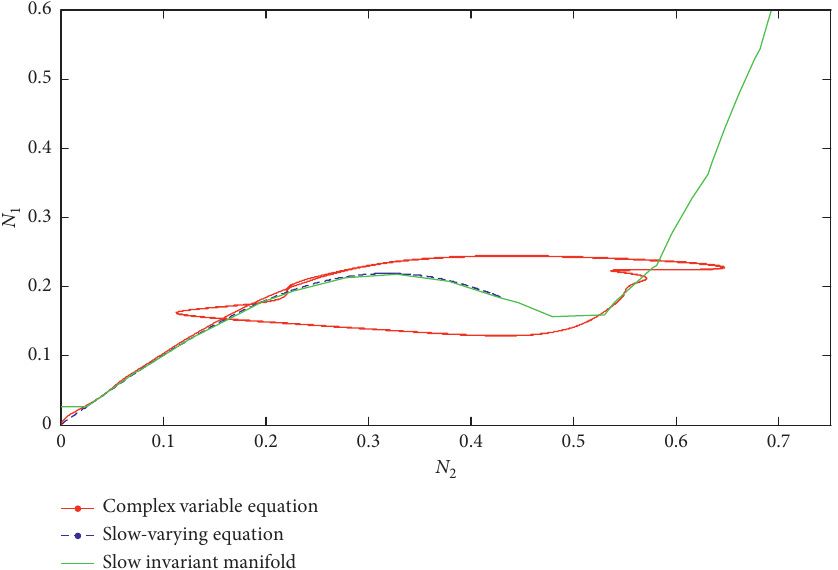
Figure 11: Slow invariant manifold of the system for the case λ